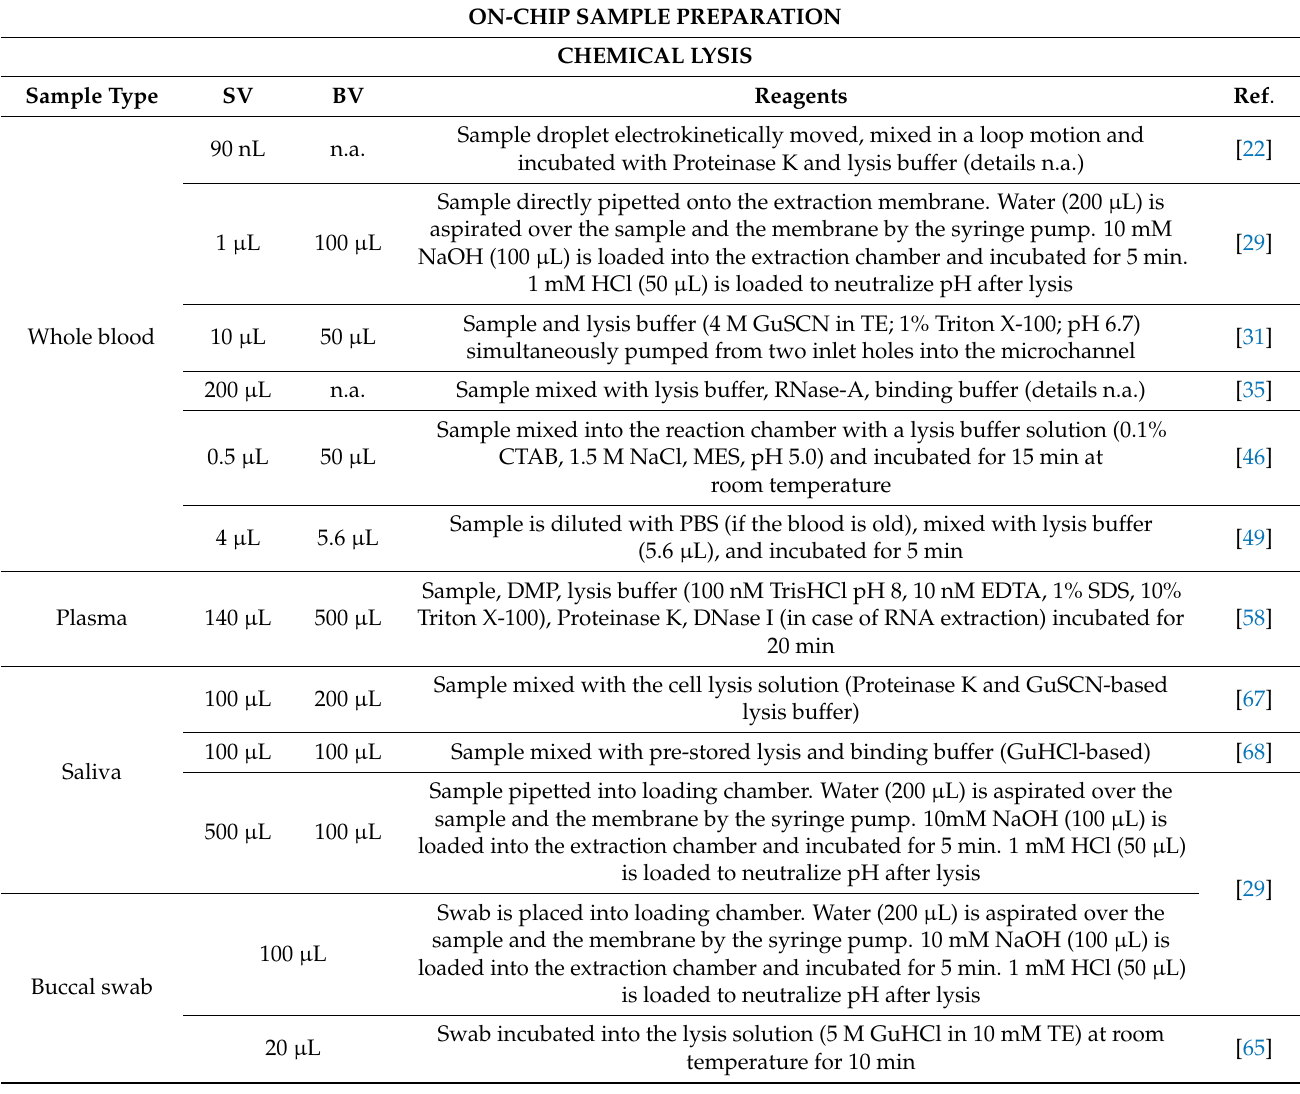
Table 2. Pre-treatment procedures applied to different sample types and in diverse LOC strategies. In details: guani- dinium salts, principally GuHCl (Guanidine hydrochloride) and GuSCN (Guanidine thiocyanate), are the most used chaotropic agents with the capacity of solubilizing proteins. Octylphenolethoxylate, commonly known as Triton-X100, is a surfactant used to extract and release the cellular content due to its reactivity with lipid membrane bilayer. DDT (Dithiothreitol) is primarily used to reduce disulphide bonds and, for example, deprotect thiolated DNA (sperm cells) or denature protein structures. Proteinase K is an enzyme used to digest protein contaminants and inactivate nucleases. Tris (tris(hydroxymethyl)aminomethane) is able to maintain pH of the buffer at a stable point, usually 8.0, and to interact with lipopolysaccharides of the membrane, destabilizing it; EDTA (ethylenediaminetetraacetic acid) is a chelating agent which binds to metal ions (e.g., magnesium and calcium), making them unavailable for other reactions such as those related to DNases activity, or breaking Gram-negative bacteria walls. SDS (sodium dodecyl sulphate) is a protein denaturing detergent. CTAB (cetyltrimethylammonium bromide) solubilizes membrane lipids and promotes cell lysis. Lysozyme is an antimicrobial enzyme able to break thick peptidoglycan structures and lyse Gram-positive bacteria, useful when aiming at infection detections. NaOH is used to perform alkaline lysis of membranes by the saponification of lipids. RNases catalyze RNA degradation. SV = Sample volume; BV = Buffer